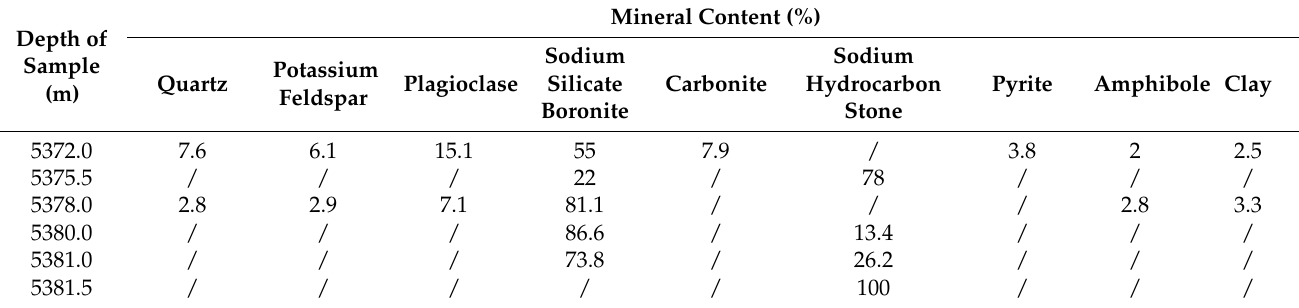
Table 1. Mineral analysis